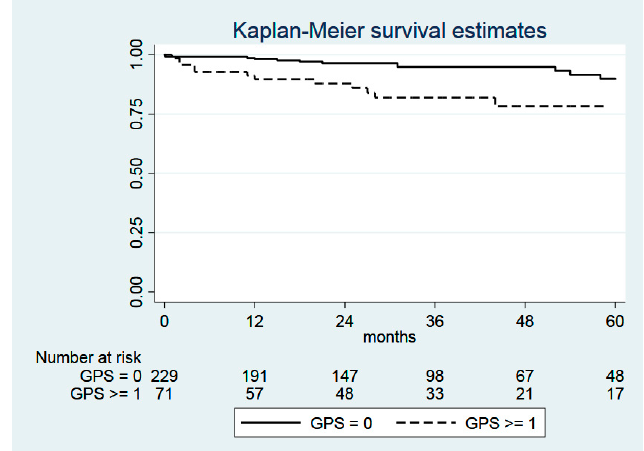
Figure 1. Kaplan–Meier curves comparing the non-cancer-related survival of patients with GPS = 0 ( n = 229) and with GPS ≥ 1 ( n = 71). Log-rank test: χ 2 = 5.81, p = 0.0159. Abbreviation: GPS, Glasgow Prognostic Score.